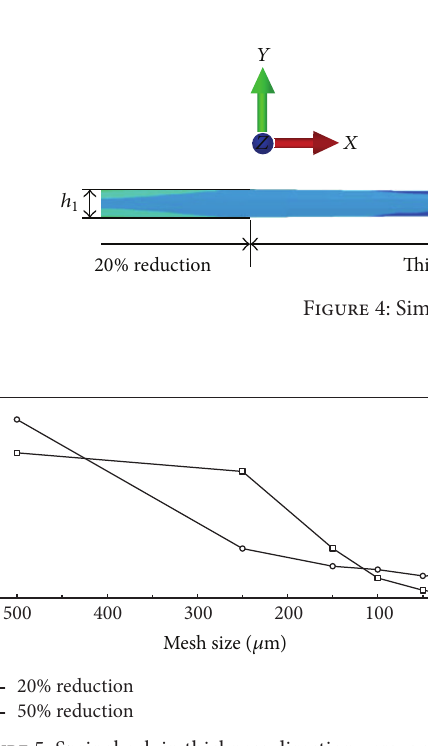
Figure 5: Springback in thickness direction versus mesh size using hexahedron elements.